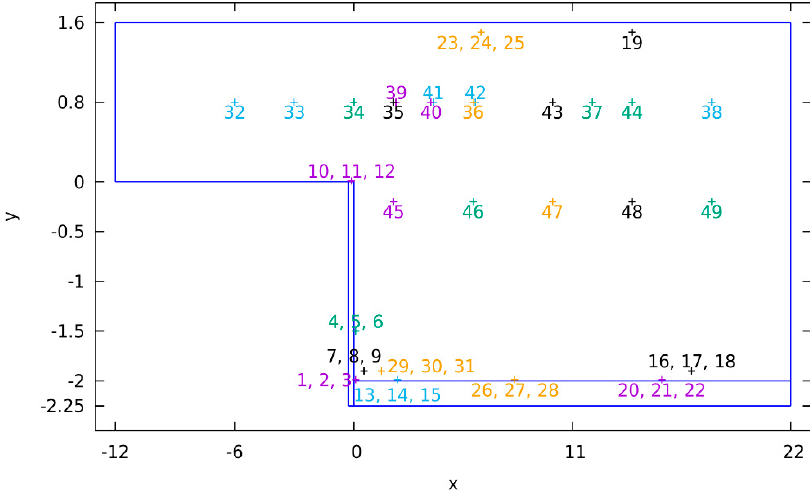
Figure 2. Distribution of points as seen from positive 𝑧 axis.